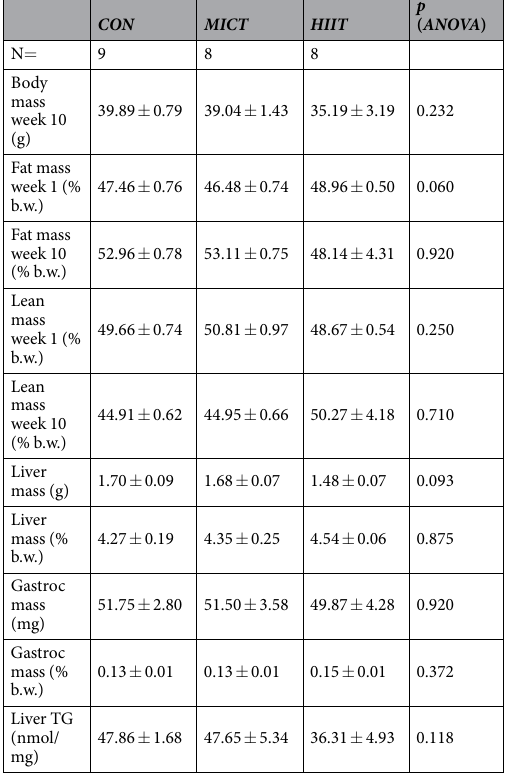
Table 1. Mice characteristics before and after